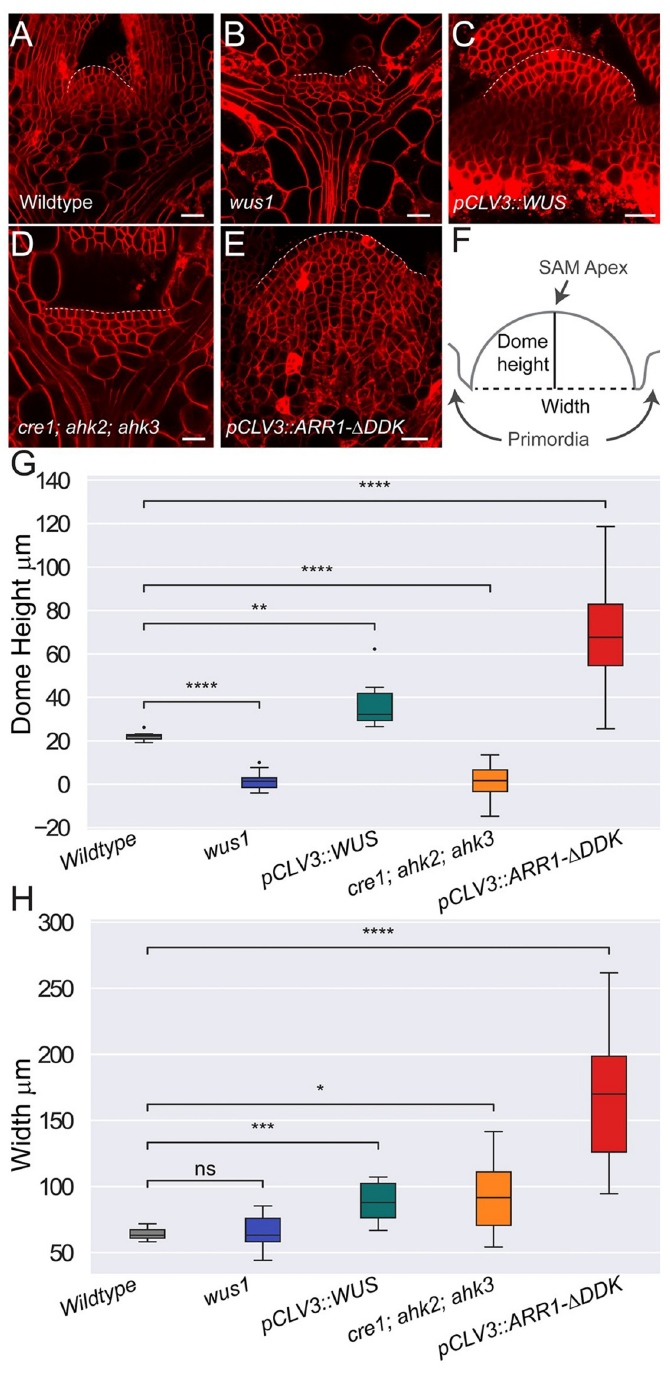
Fig 3. WUS and CK regulate SAM size and shape. Representative median longitudinal section of vegetative meristems in the (A) wildtype [l er ], (B) wus1–1 , and (D) cre1–12;ahk2–2;ahk3–3 backgrounds. 48 hour Dex induction of (C) ectopic misexpression of WUS [pCLV3::LhG4; 6xOP::eGFP-WUS-GR] and (E) ectopic misexpression of CK [pCLV3::LhG4; 6xOP::ARR1- Δ DDK-GR] signaling. SAM dome has been outlined by white-dashed line. Scale bar = 20 microns. Image intensity and gain were increased in images (A,C, and D). (F) SAM dome height was measured from the primordia to the distal portion of the SAM and SAM width was measured from the apical junction of the nearest flanking primordia (see S3 Appendix for details). (G) Dome height and (H) width were determined for each experimental condition shown in (A-E). Significance tests in (G-H) were performed using independent t-tests. Asterisks indicate significance at the following levels: � (p � 0.05), �� (p � 0.01), ��� (p � 0.0001), ���� (p � 0.00001), ns (p >